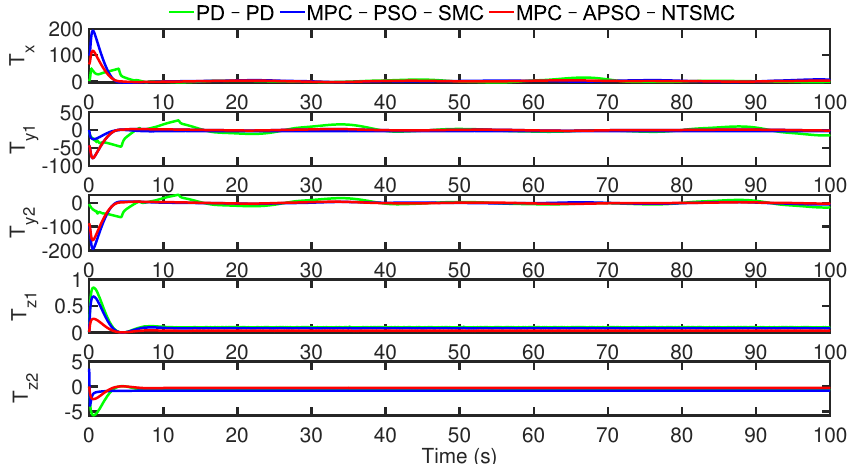
Figure 23. The thrust of thrusters for the tracking task without disturbance for Case